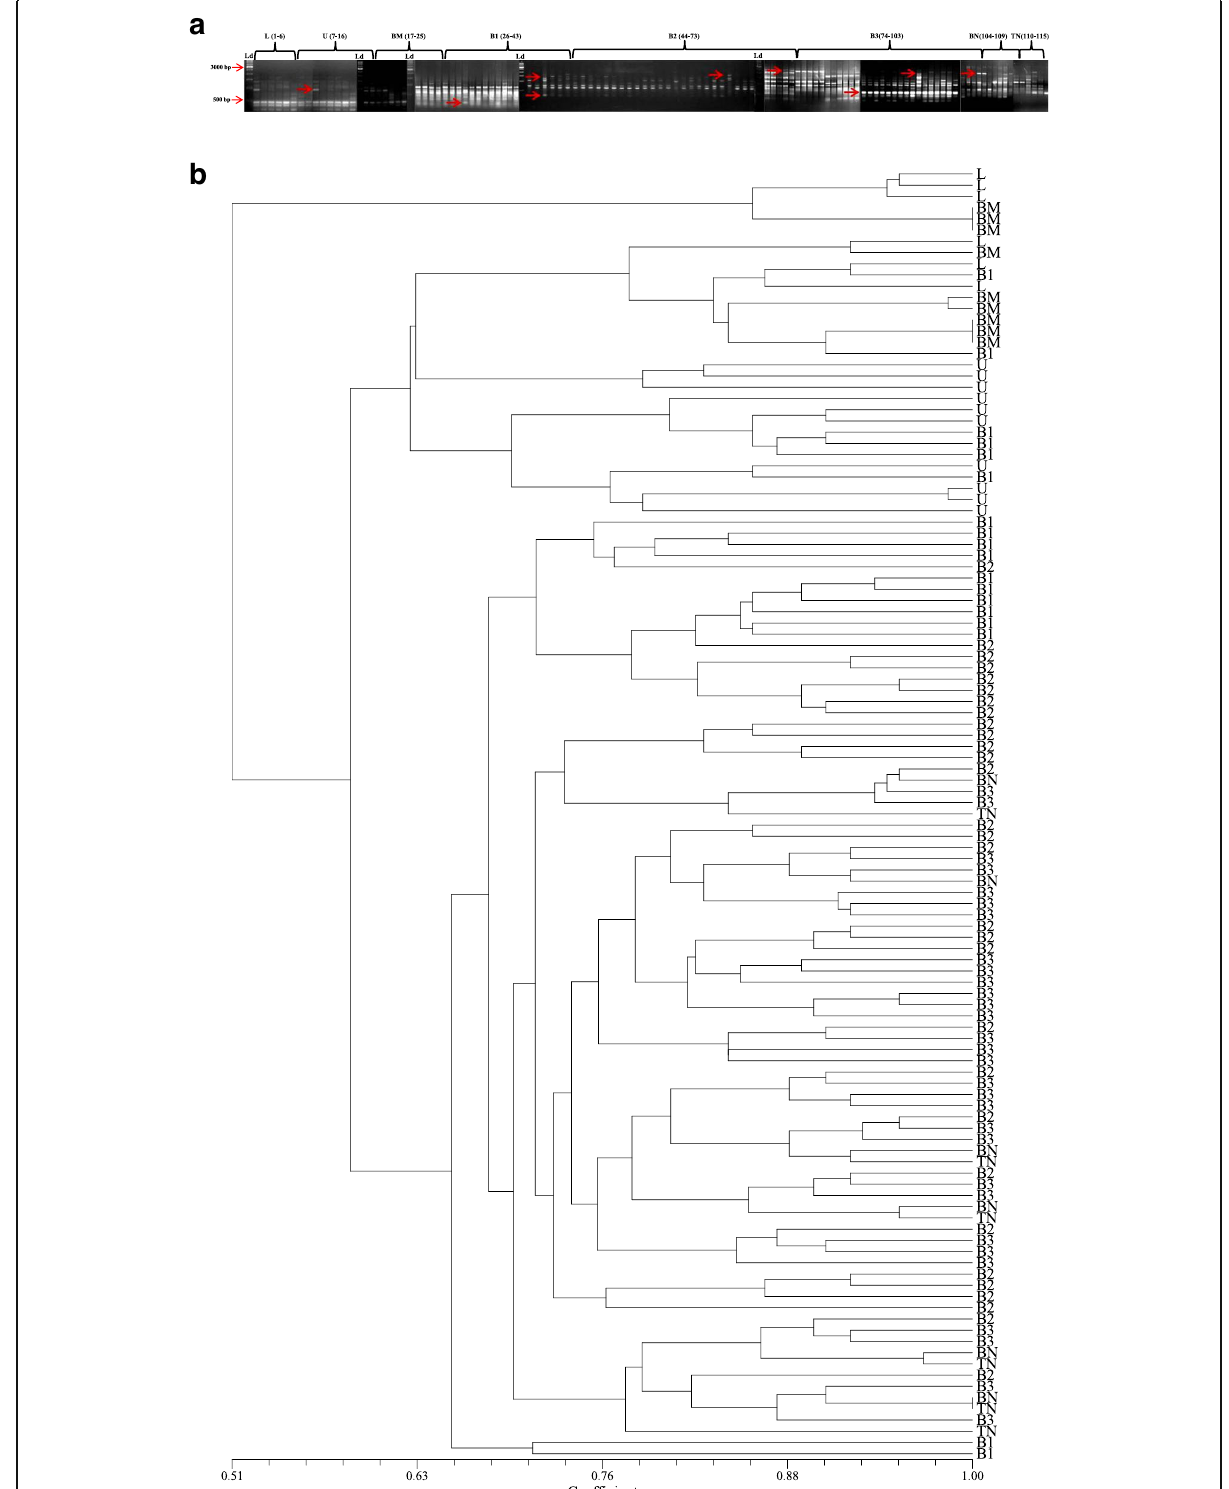
Fig. 5 DAMD profiles; a Banding profile in I . griffithii populations using URP 38F, b genetic distance recorded with DAMD primers